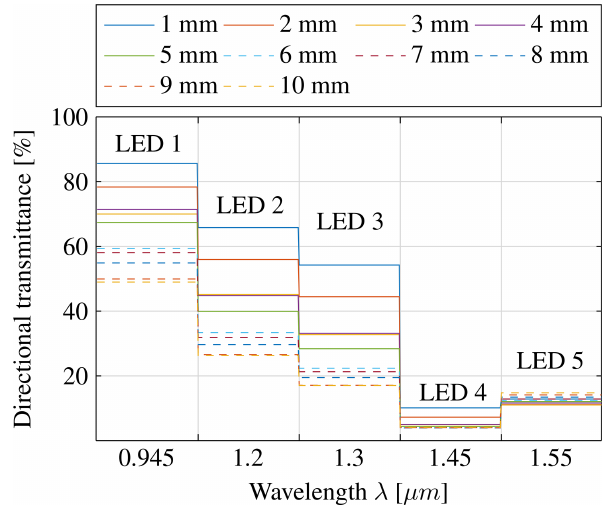
Figure 9. Measurements of water film heights from 1 to 10mm on a white tile surface at a distance of 5cm.